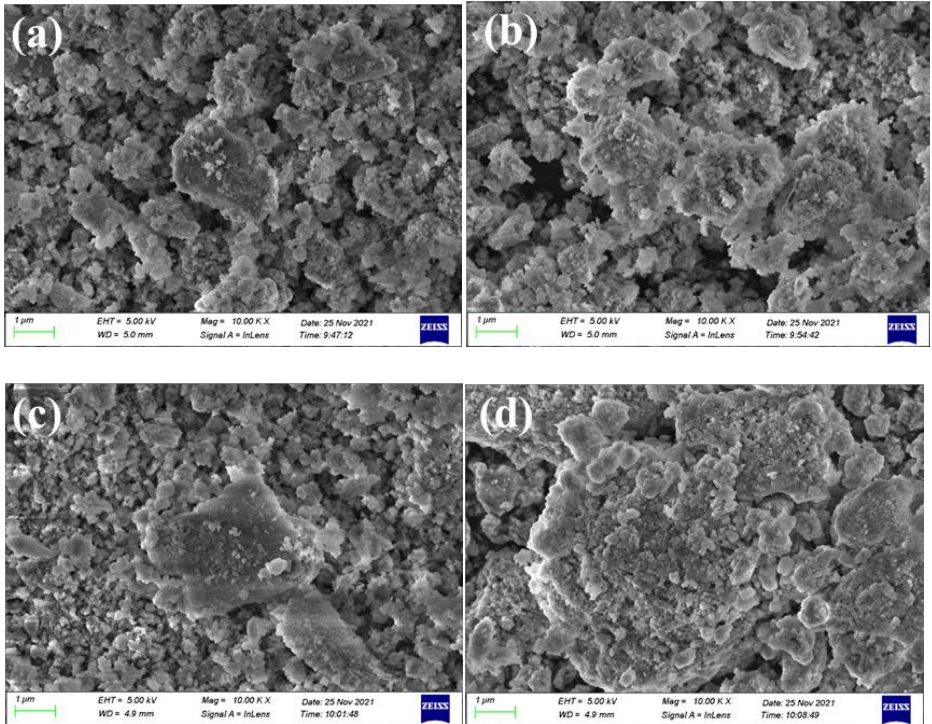
Figure 8. 10k SEM image of desulfurized red mud. (( a ) raw red mud desulfurization; ( b ) ball mill red mud desulfurization; ( c ) desulfurization of raw red mud under ultrasonication; ( d ) desulfurization of ball-milled red mud under ultrasonication).